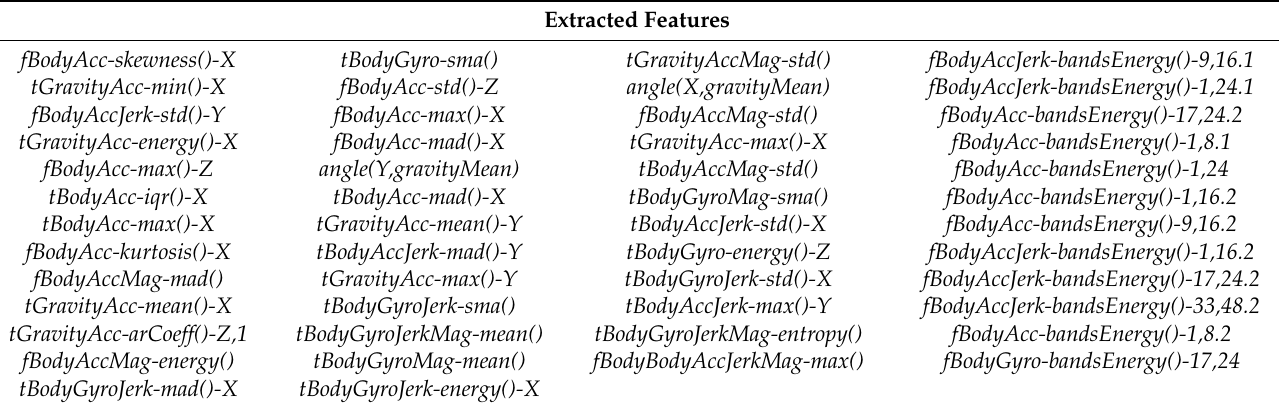
Table 2. List of extracted key features. Extracted Features